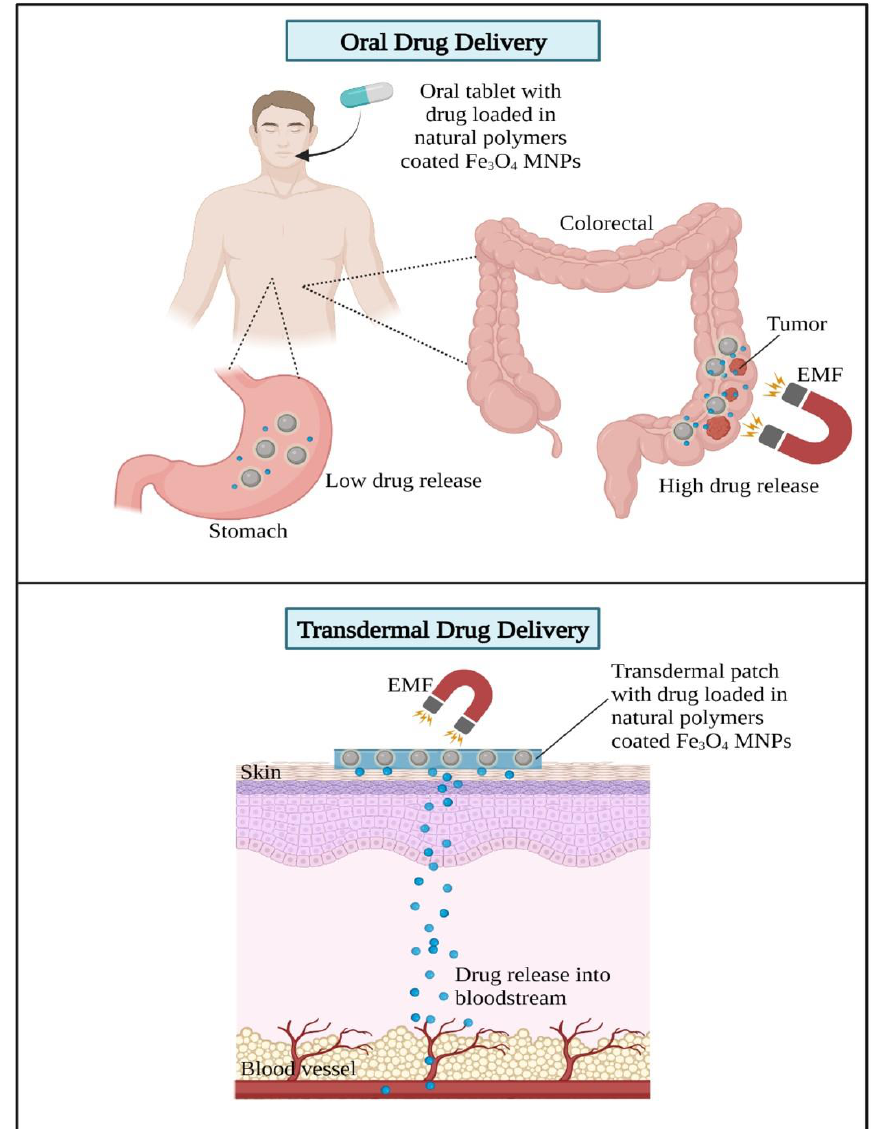
Figure 14. Mechanism of actions of oral drug and transdermal drug delivery by Fe 3 O 4 MNPs. Oral drug delivery: Oral route administration is achieved by ingesting an oral tablet containing a drug loaded in the natural polymer coated with Fe 3 O 4 MNPs. Stable Fe 3 O 4 MNPs only produce a slow drug release in the stomach but high drug release in the targeted site such as in the colorectal region upon exposure to an external magnetic field (EMF). Transdermal drug delivery: a transdermal patch with the drug loaded in natural polymers coated with Fe 3 O 4 MNPs is placed on the skin, and an EMF is applied to trigger drug release from the Fe 3 O 4 MNPs directly into the bloodstream.